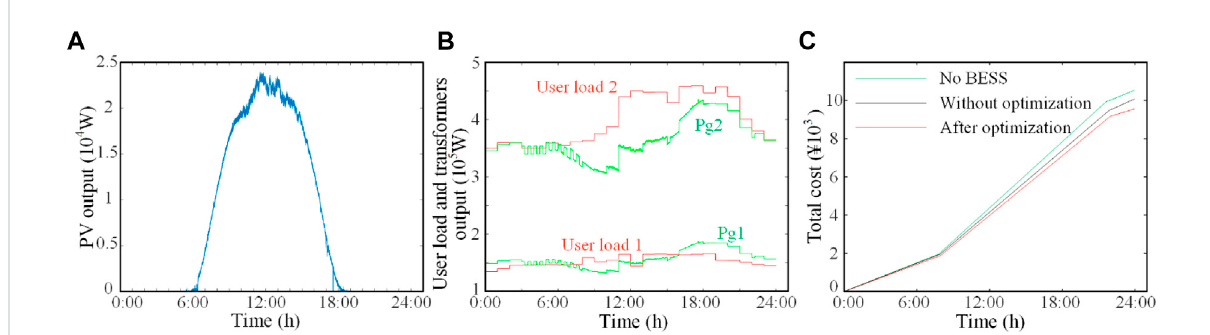
FIGURE 8 24-h (A) PV output curve, (B) user load and transformers output, (C) electricity cost curve.